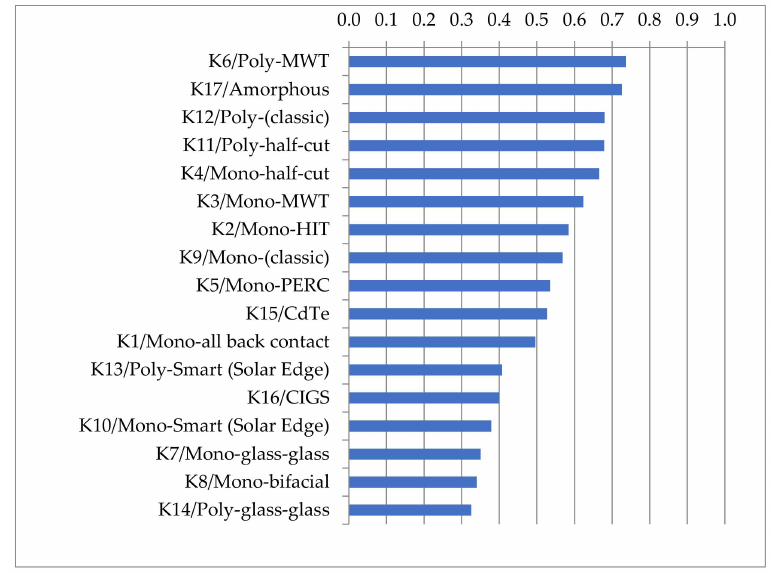
Figure 3. Visualization of the ranking of photovoltaic panel technology types based on “Option 2” assumptions.